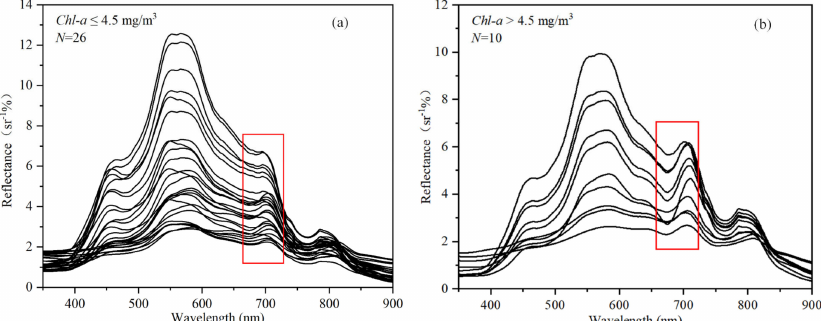
Figure 2. The reflectance spectrum curves of the water surface at the sampling sites (N denotes the number of samples). ( a ) The in situ water surface reflectance spectrum of sampling sites with chl-a concentration ≤ 4.50 mg/m 3 ; and ( b ) in situ water surface reflectance spectrum of sampling sites with chl-a concentration >4.50 mg/m 3 . The spectrum in the red box shows the spectral characteristics caused by